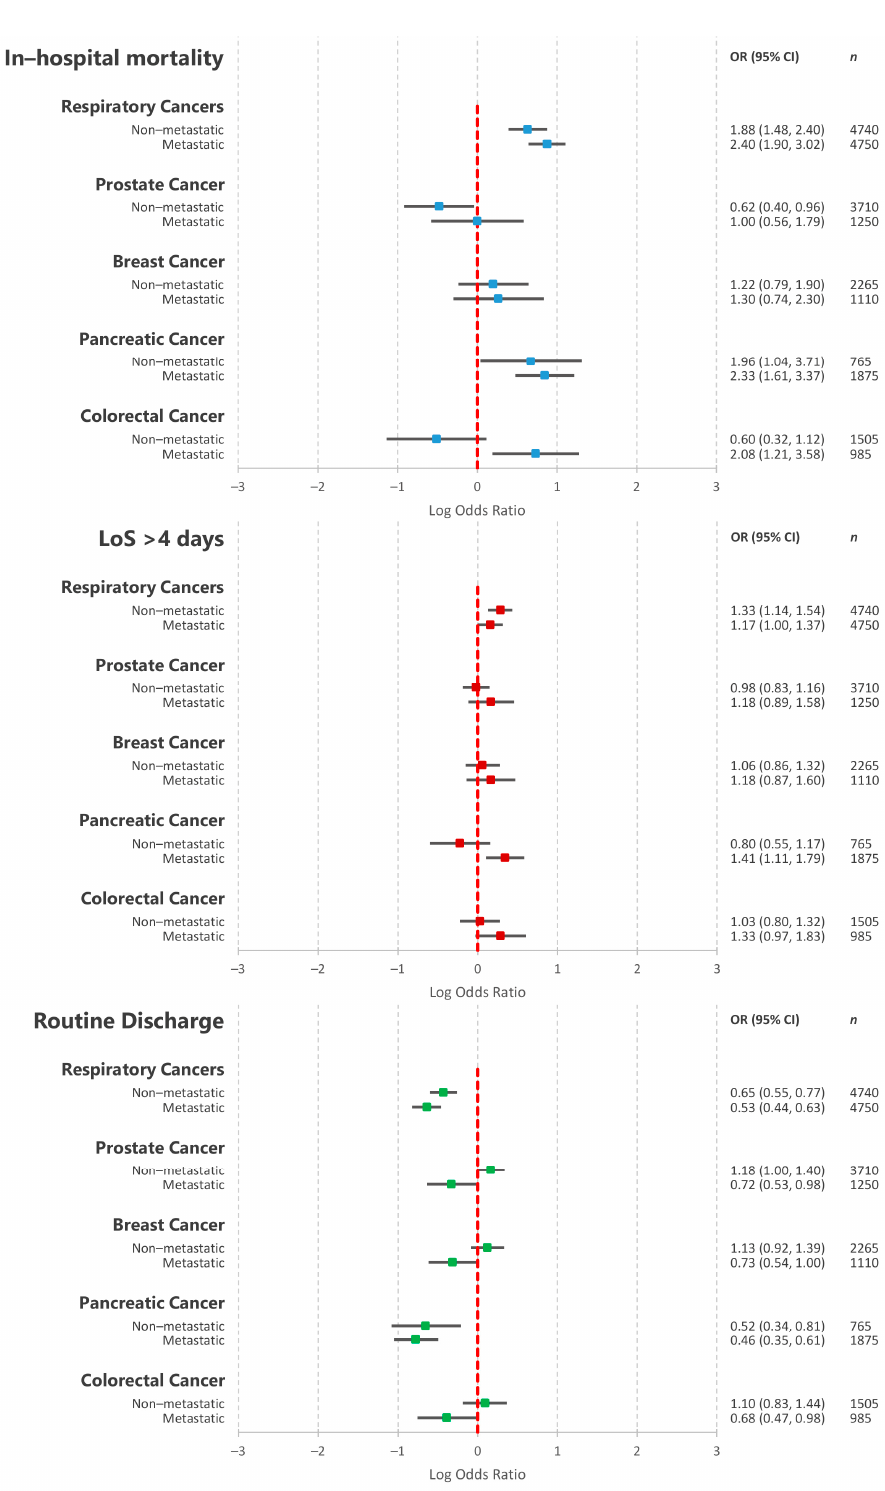
Figure 5. Results of multivariable logistic regressions assessing the association between the 5 most commonly occurring cancer types in the included cohort and acute ischaemic stroke in-hospital mortality as well as the interaction with revascularisation therapies. OR—odds ratio; CI—confidence interval; IVT—intravenous thrombolysis; ET—endovascular thrombectomy.